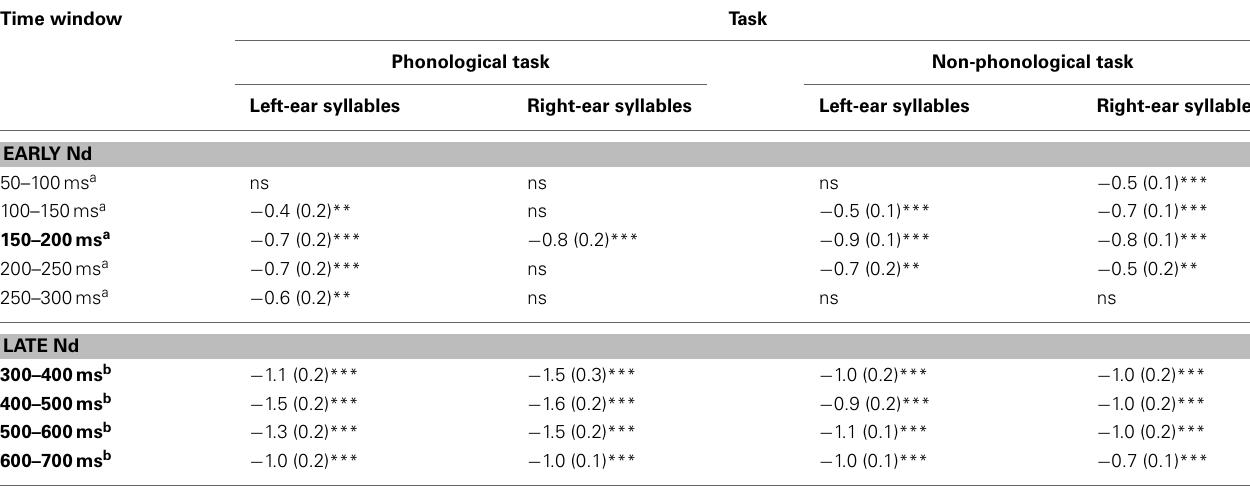
Table 1 | Mean amplitudes ( µ V, standard errors of the mean in parentheses) calculated from difference waveforms (see Figure 4) for the early-Nd and late-Nd effects of auditory attention on ERPs to spoken left-ear and right-ear syllables during phonological and non-phonological tasks at Cz electrode at different time windows from syllable